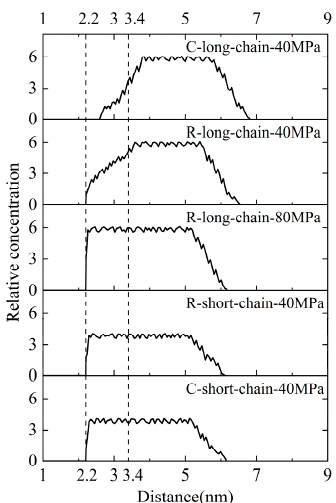
Figure 4. Concentration profile of PC atoms in CIM and RHCM at the end of the packing stage. The distance between 2.2 and 3.4 nm is the depth of mold cavity. C and R in graphs indicate CIM and RHCM, respectively.